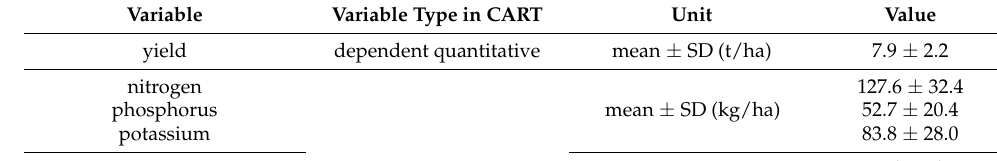
Table 1. Variables used in the CART